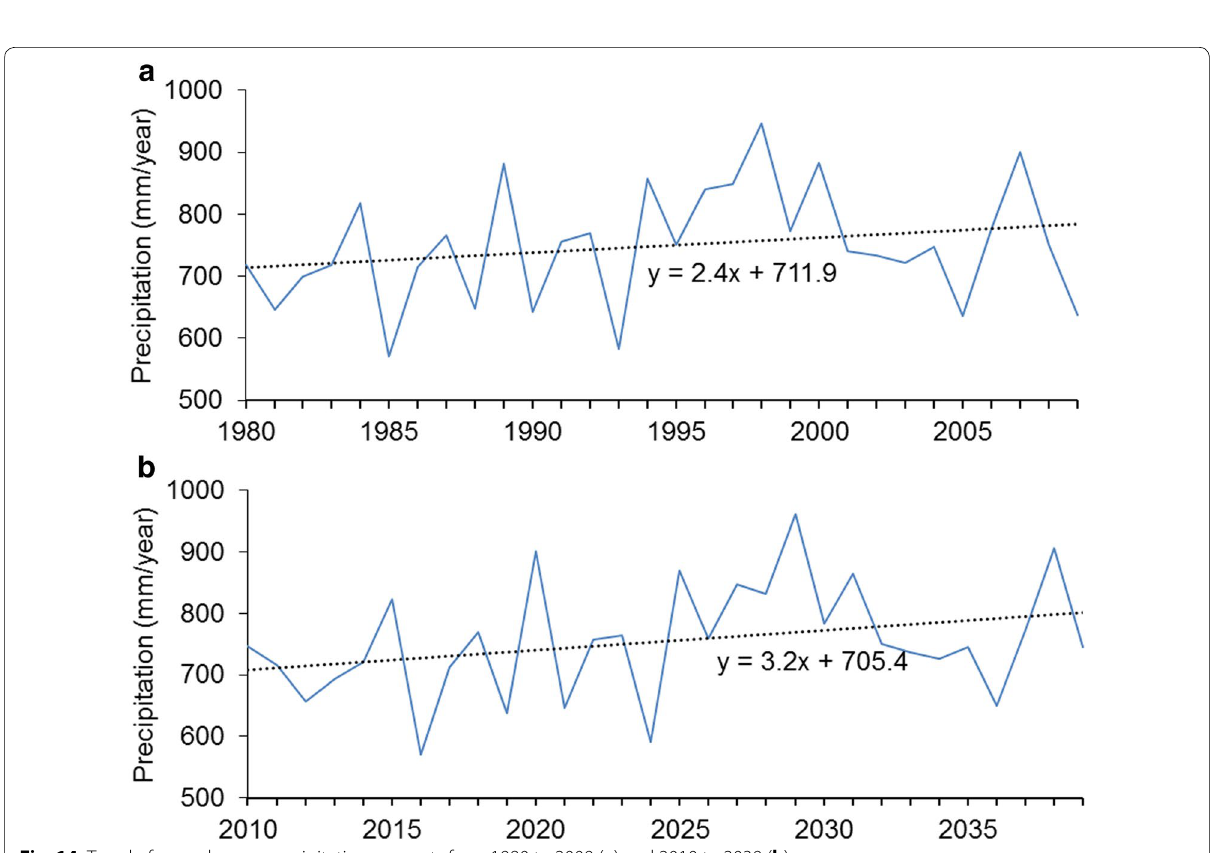
Land use/cover change and its impact on the catchment water balance The largest future land use/cover change between 2013 and 2020 were observed in the mixed forest lands (Fig. 18). The mixed forest land decreased by